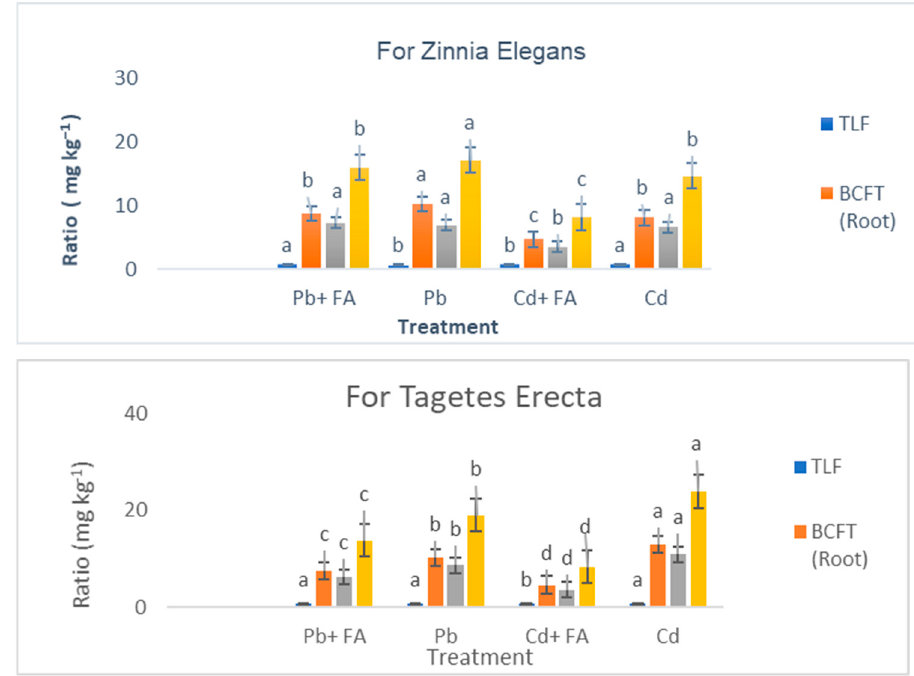
Figure 1. Effects of FA application on remediation component of Tagetes eracta and Zinnia Elegans under growth with different Pb and Cd amendments. Notes. Different letters within the columns show significant differences at p 0.05 for heavy metal and FA applications; Remediation Factors, Bioconcentration factor (BCFT) (stem and root) relative to total soil element (B, Pb or Cd); Translocation factor (TLF)